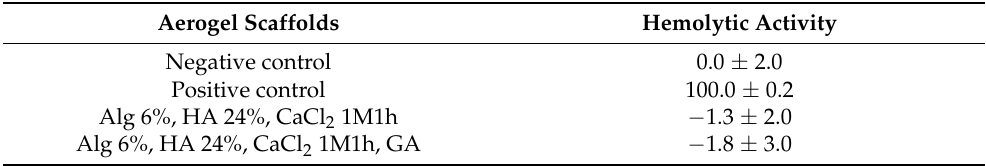
Table 3. Hemolytic activity tests for aerogel scaffolds. Positive control: Triton solution + blood; negative control: PBS solution pH 7.4 + blood.